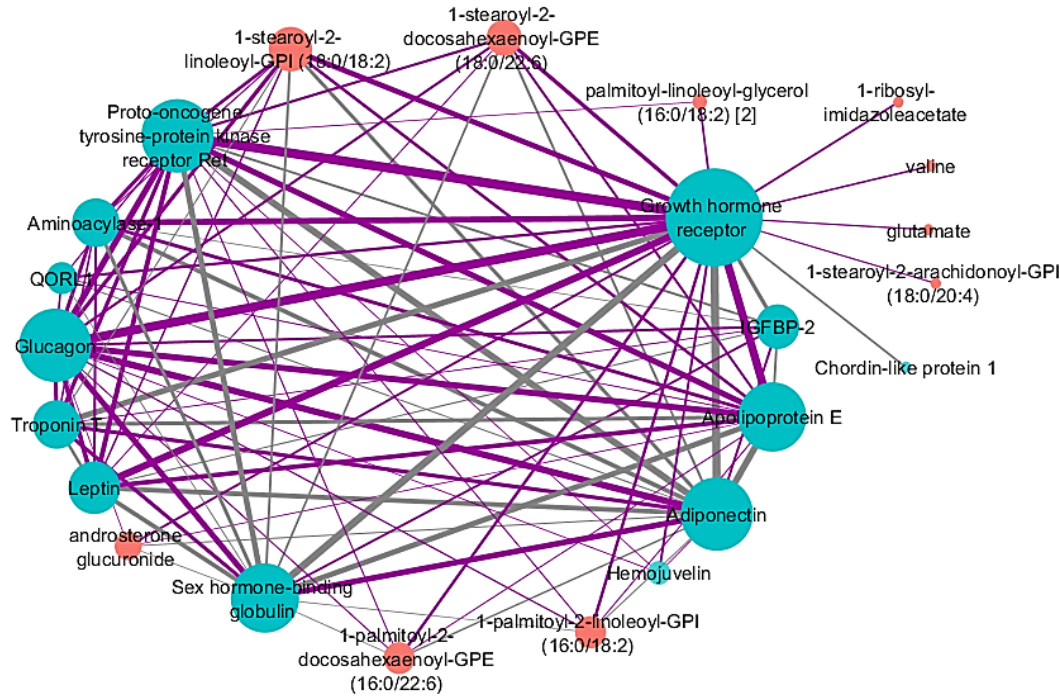
Figure 2. Identified network after applying SmCCNet to adjusted proteomic and metabolomic data and percent emphysema. Proteins are blue nodes and metabolites are red nodes. Grey edges represent a negative correlation between the nodes. Purple edges represent a positive correlation between the nodes. Edge thickness corresponds to the relationships between the nodes based on the canonical weights. Node size corresponds with connectivity. Abbreviations: insulin-like growth factor-binding protein 2 (IGFBP-2), quinone oxidoreductase-like protein 1